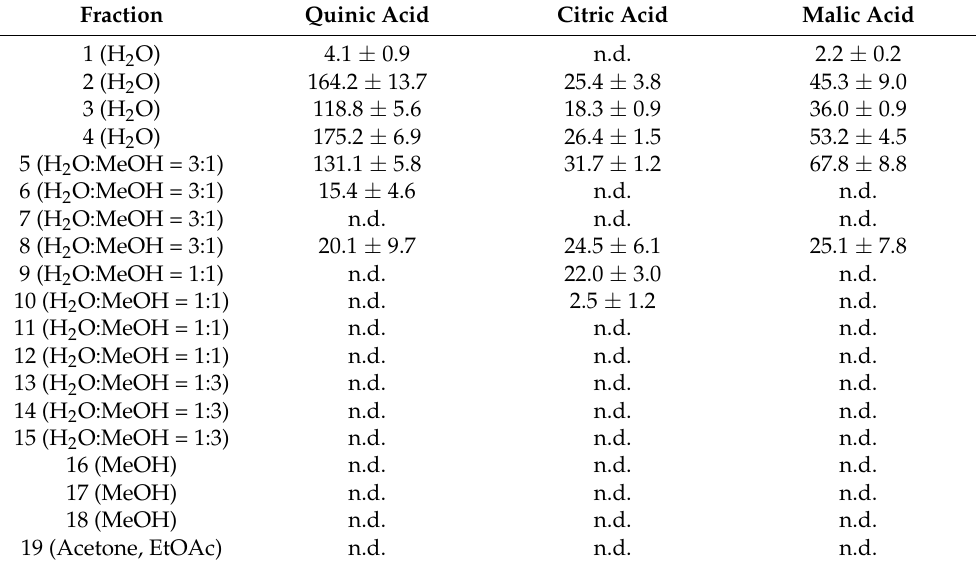
Table 3. Organic acid content of fractions from water extracts of V. virgatum stems (mg/g (dry weight of